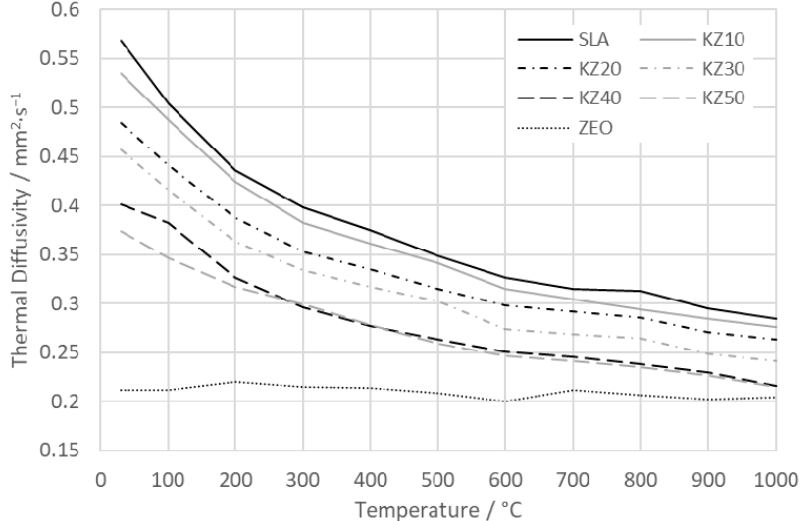
Figure 10. Thermal diffusivity of the studied samples.